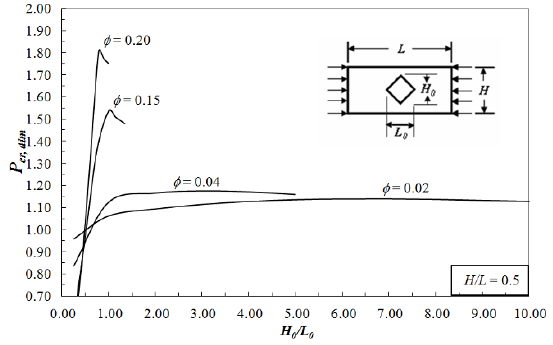
Figure 10. Plate with centered diamond hole: optimization of the critical buckling